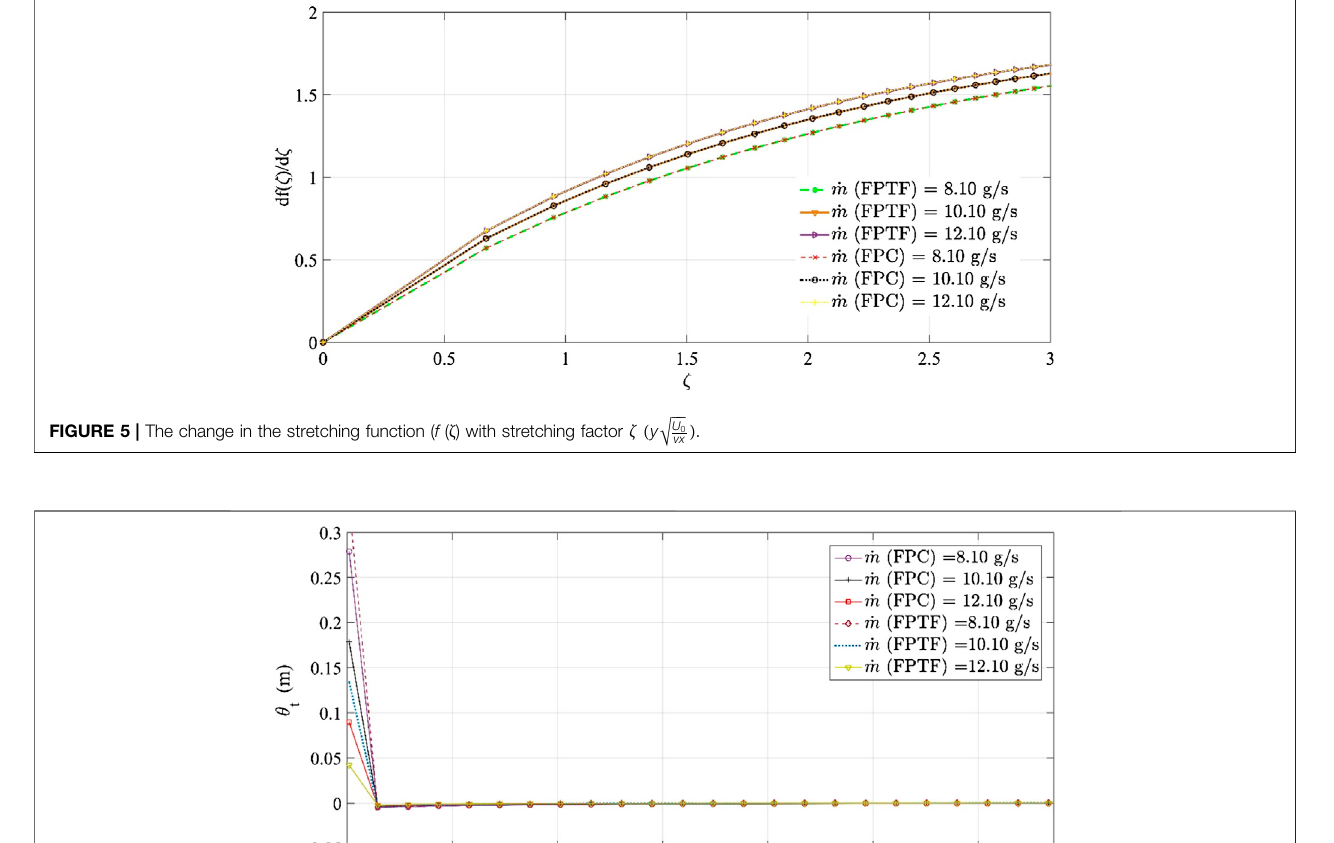
FIGURE 6 | The variation of momentum thickness ( θ t ) as a function of the length of absorber plate ( x ).